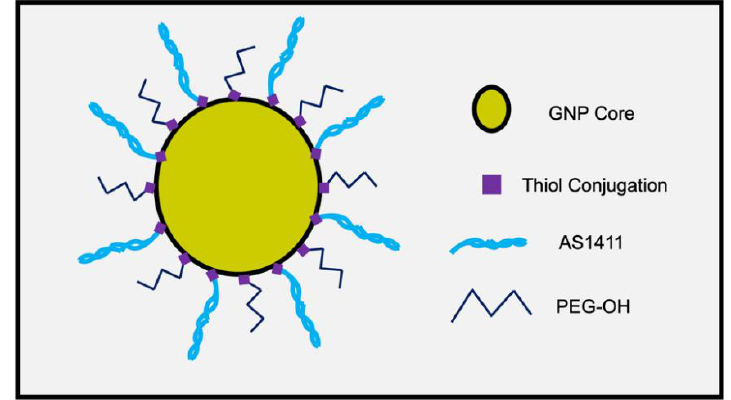
Figure 1. Schematic of PEG-AS1411 co-conjugated 4 nm GNPs.